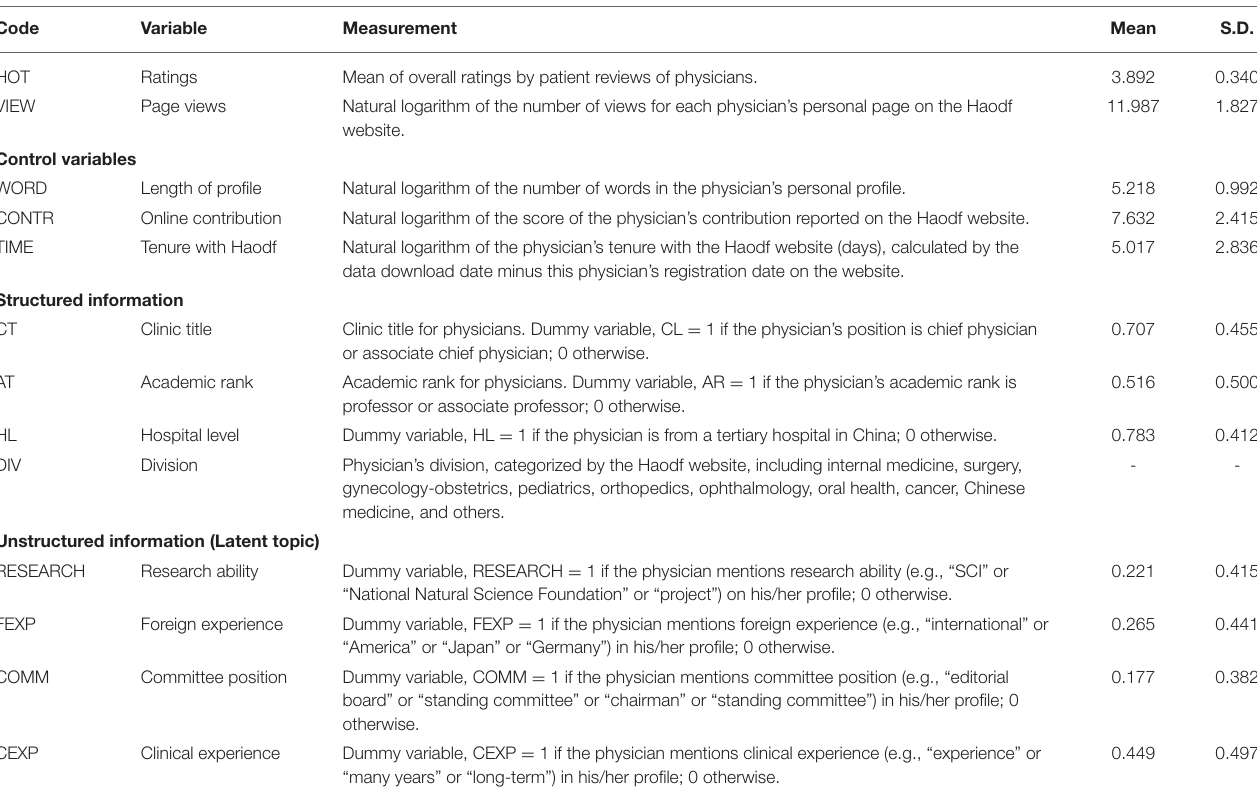
TABLE 1 | Variable measurements and descriptive